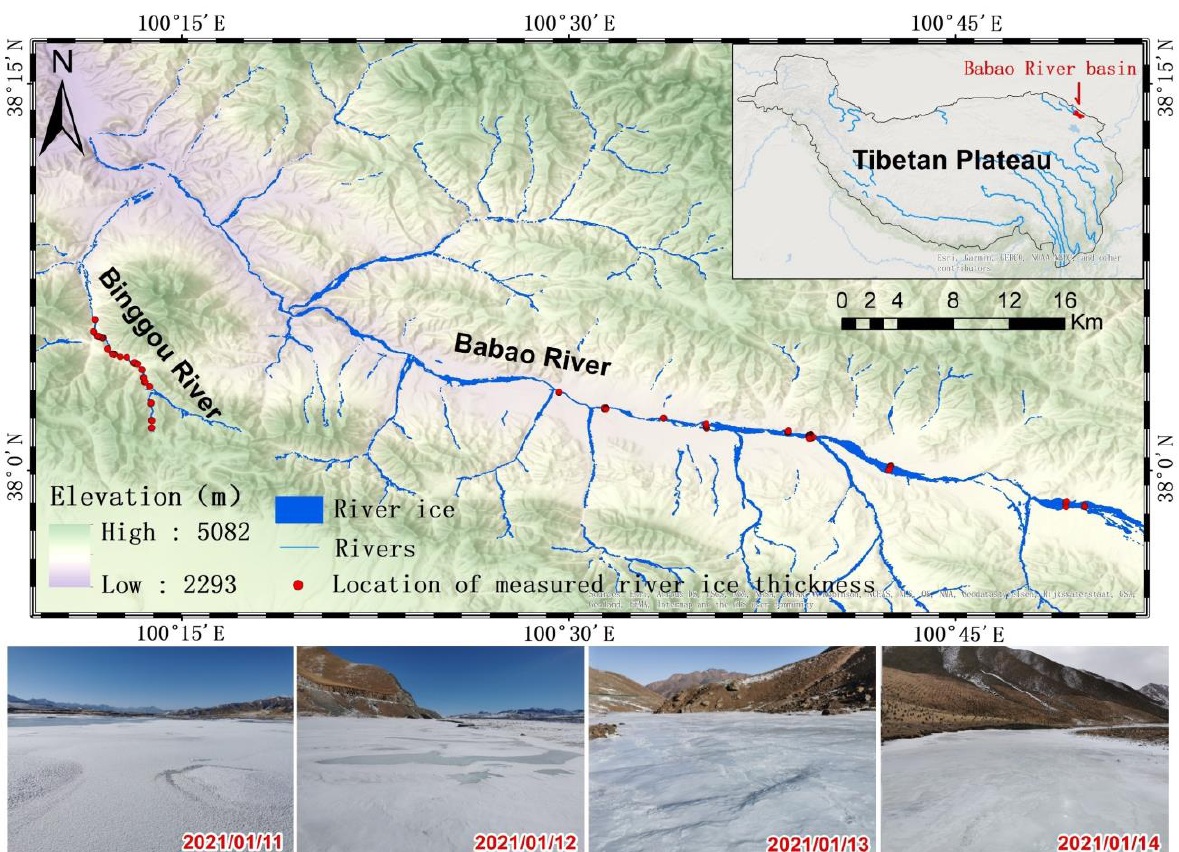
Figure 1. Overview of the study area of the Babao River basin and a map of its river ice distribution. The four photos demonstrate the status of river ice: The first two show the main stream of the Babao River, while the last two show that of the Binggou River. The locations of the river ice sampling points are indicated in the figure, and the red area in the upper-right inset delineates the location of the Babao River basin on the Tibetan Plateau.